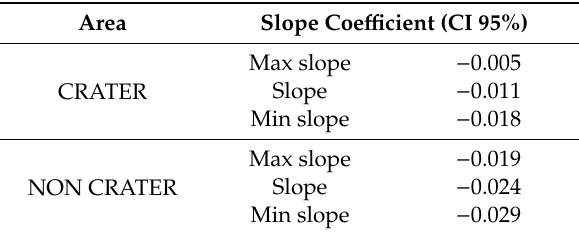
Table 2. Medium-long term analysis of SHRs regression line, coefficients (slope x 1000), for all causes between 2010 and 2015 with Confidence Intervals—data in the table below. Area Slope Coefficient (CI